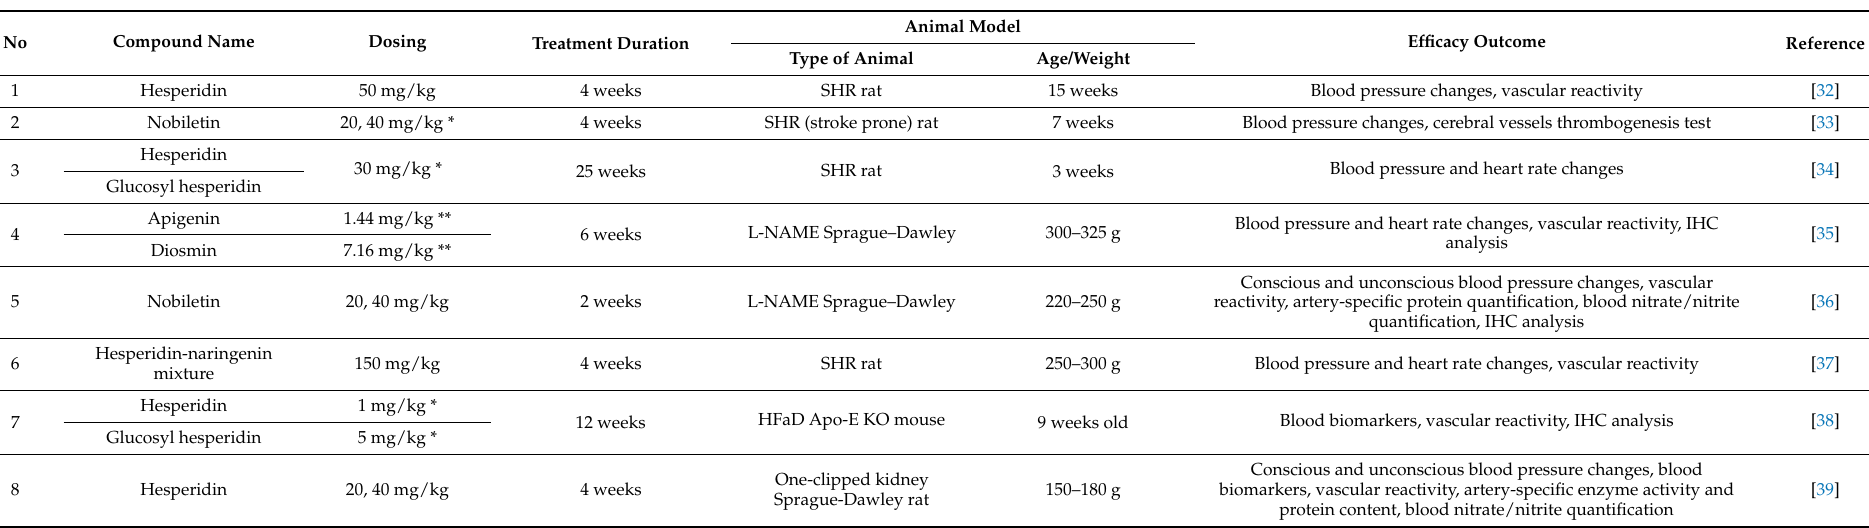
Table 2. Study design of selected articles on hypertension animal